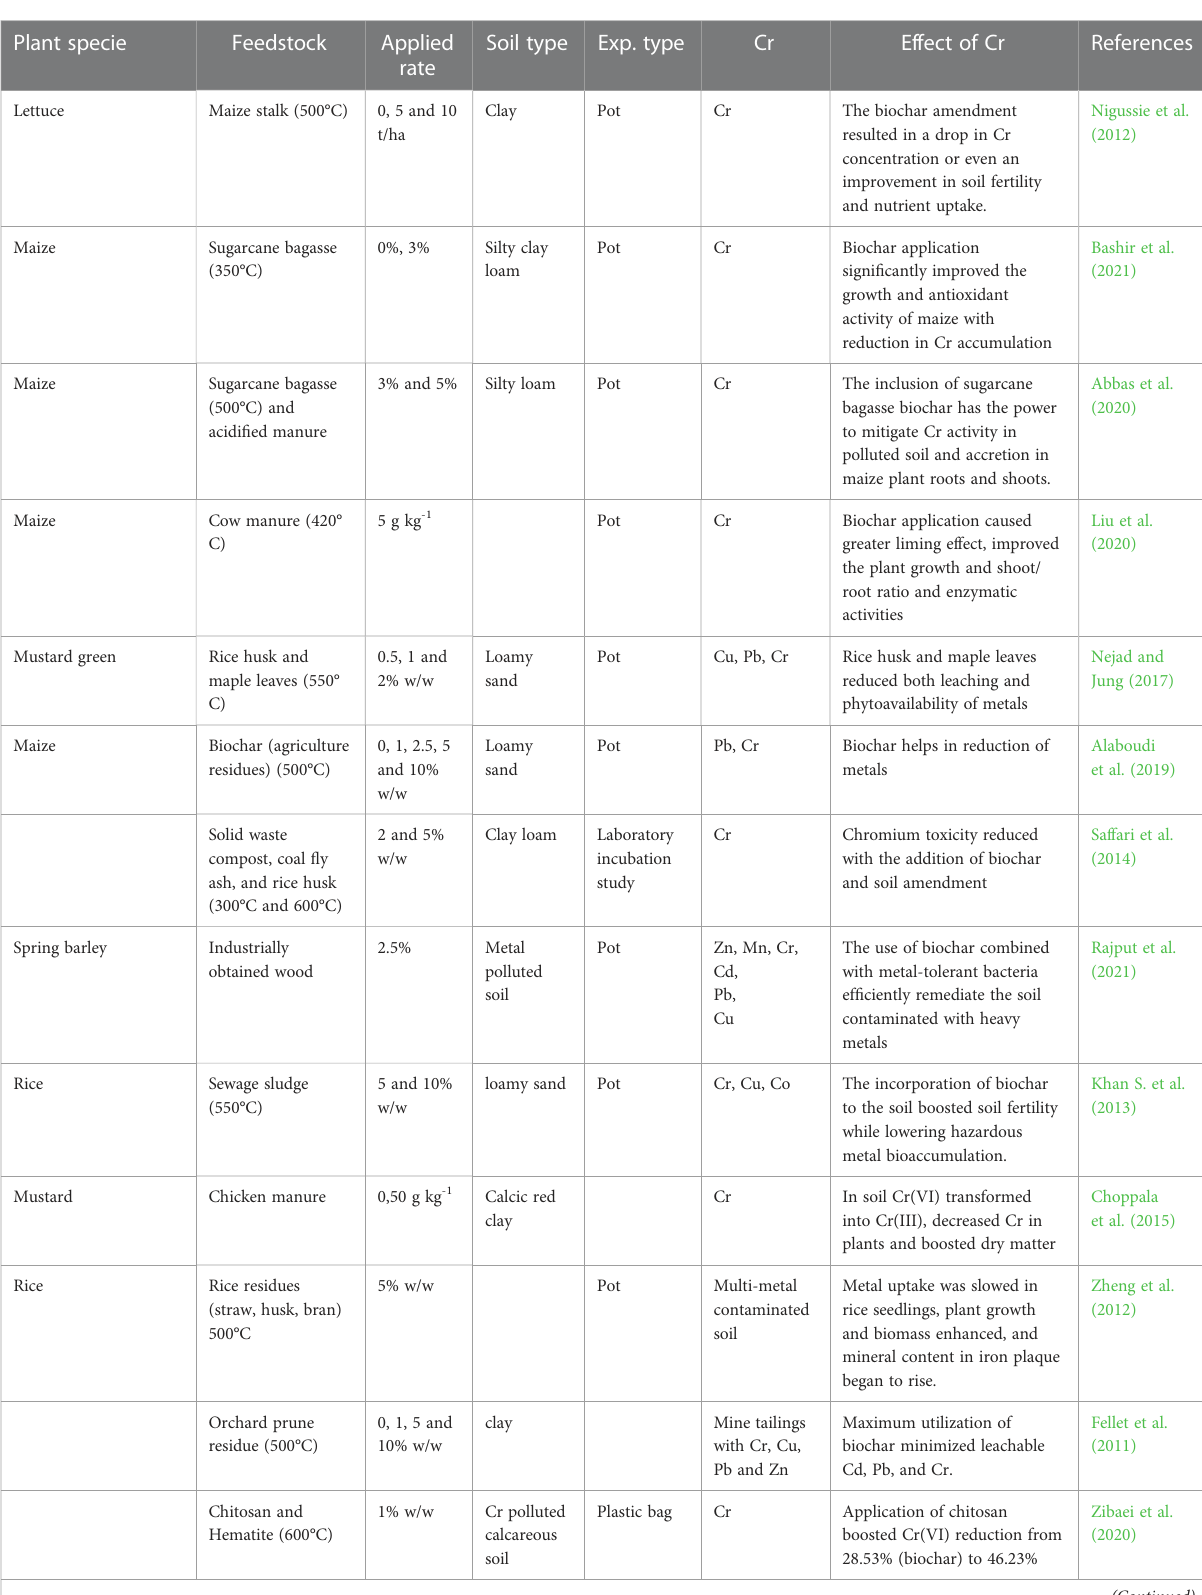
TABLE 7 Effects of biochar application on crops growth and Cr uptake, grown on Cr-contaminated